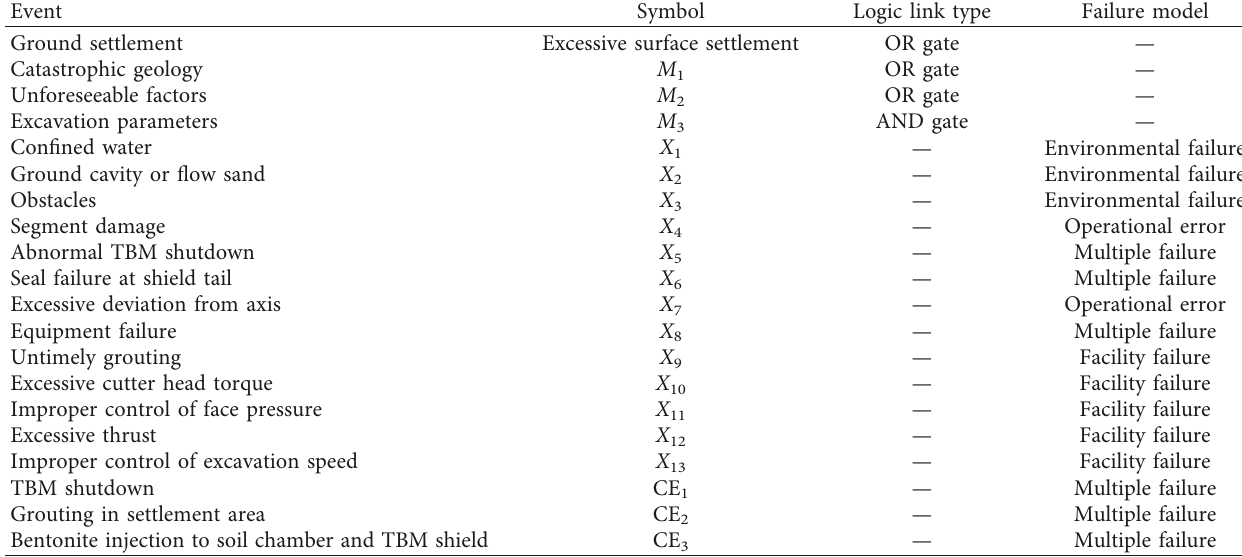
Table 9: Details of bow-tie components in Figure